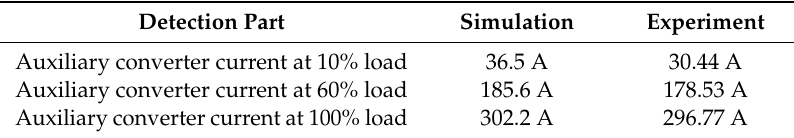
Table 5. Converter output current simulation and experimental data